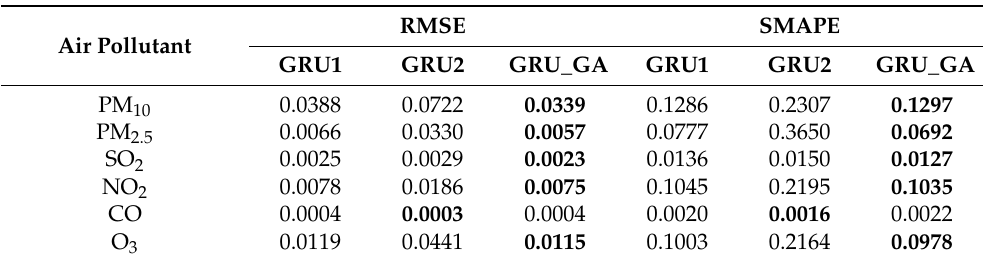
Table 11. The result of the adaptive GRU network structure compared with manually designed GRU network structures with Dataset 2.